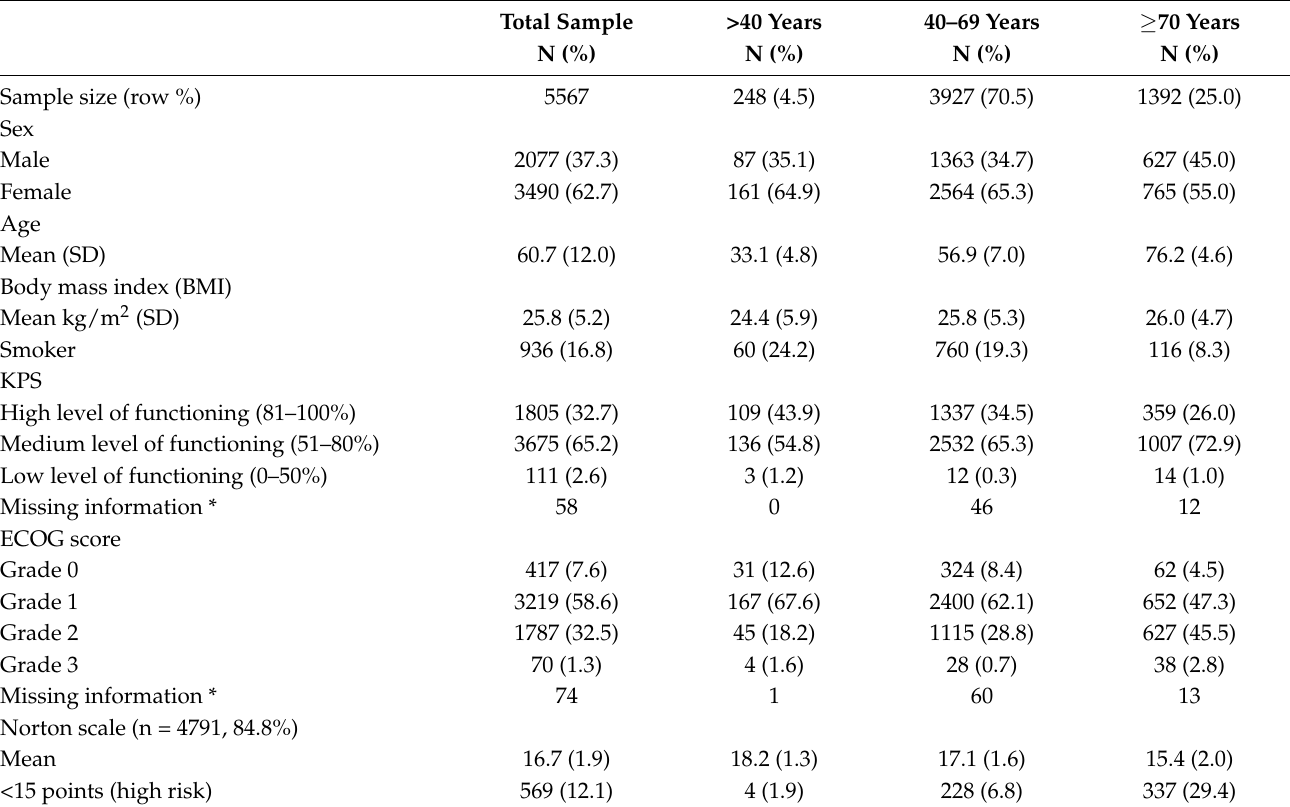
Table 1. Sociodemographic and clinical